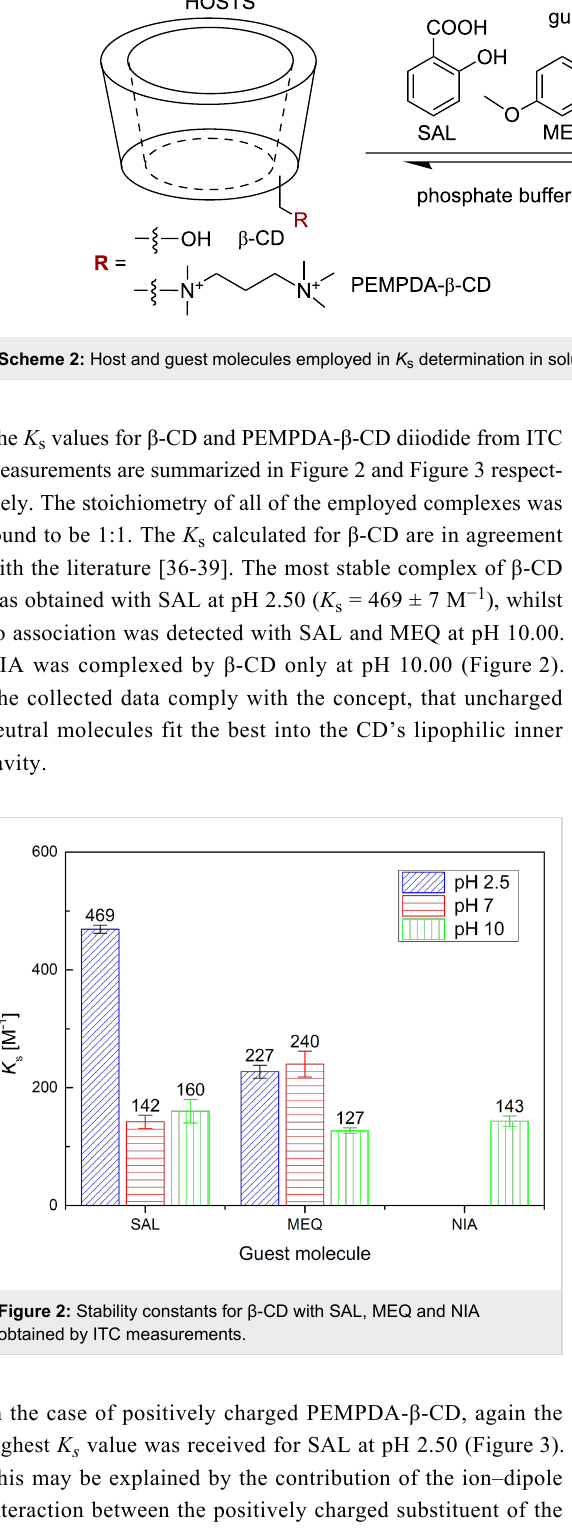
In the case of positively charged PEMPDA- β -CD, again the highest K s value was received for SAL at pH 2.50 (Figure 3).